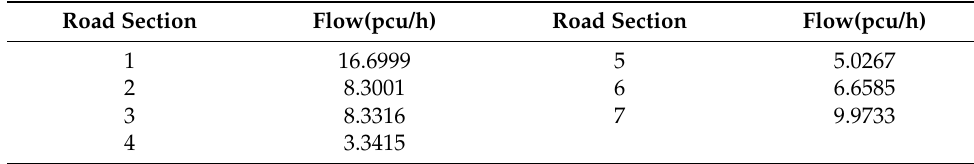
Table 3. Equilibrium solution of state 1.